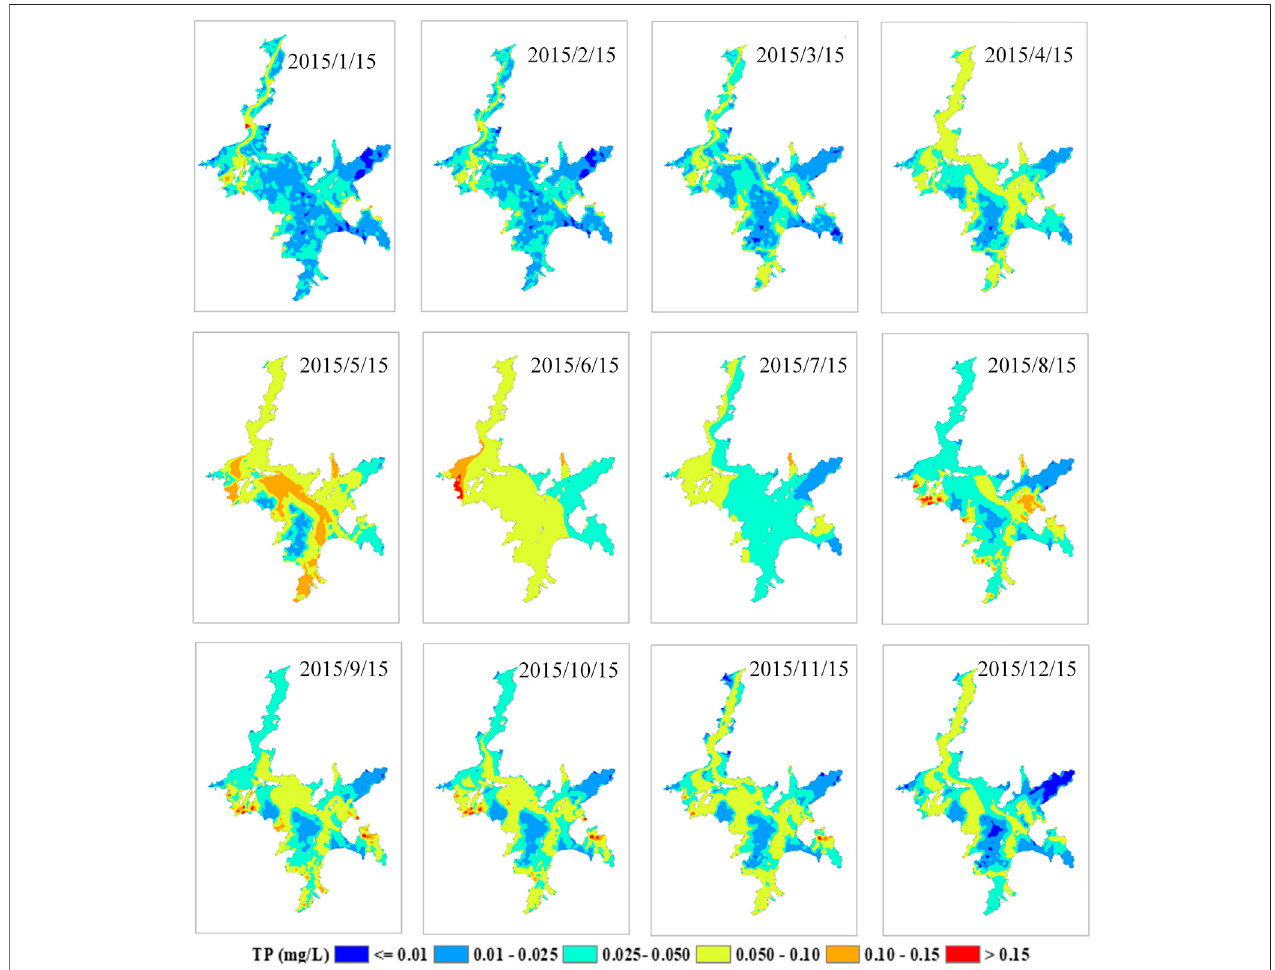
FIGURE 4 | Spatiotemporal distributions of the simulated TP concentrations in Lake Poyang in 2015.